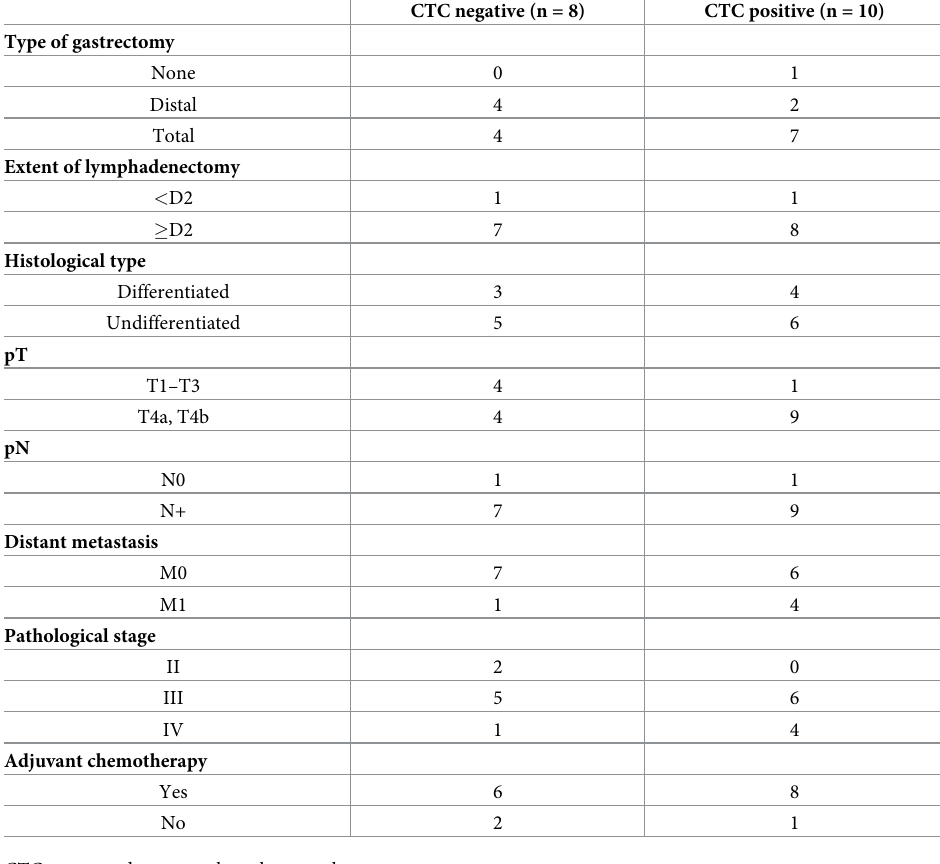
Table 2. Primary stage and previous treatment for gastric